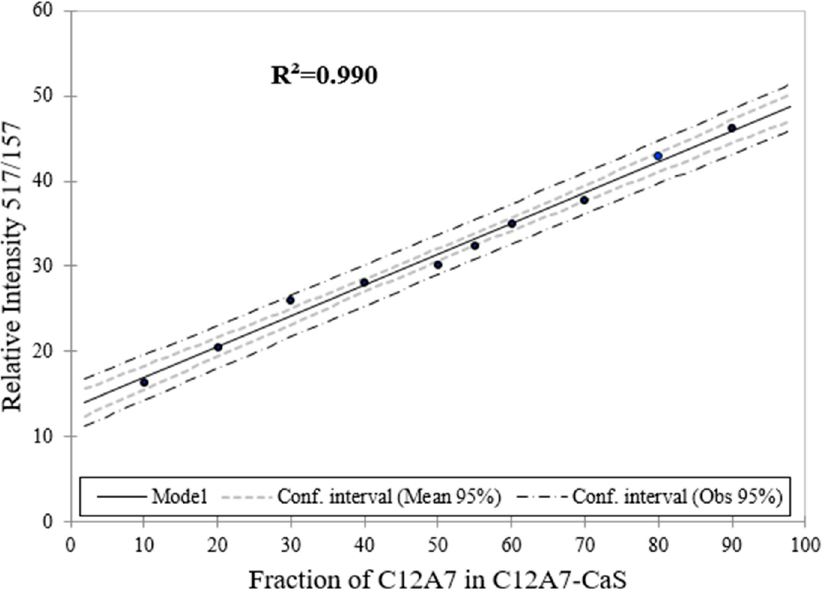
Figure 14. Raman spectroscopy estimation for the phase content (wt. %) for C12A7 as a function of the phase content of C12A7 in C12A7–CaS sample.